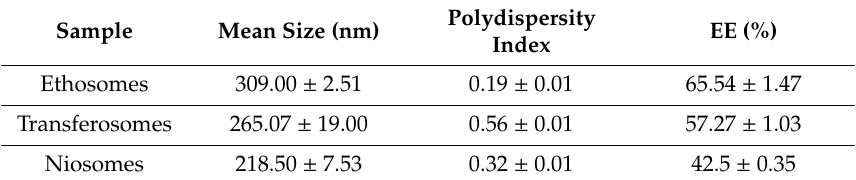
Table 4. Physico-chemical parameters of paclitaxel-loaded drug delivery systems obtained by use Zetasizer Nano ZS. Values are reported as the average of three independent experiments ± standard